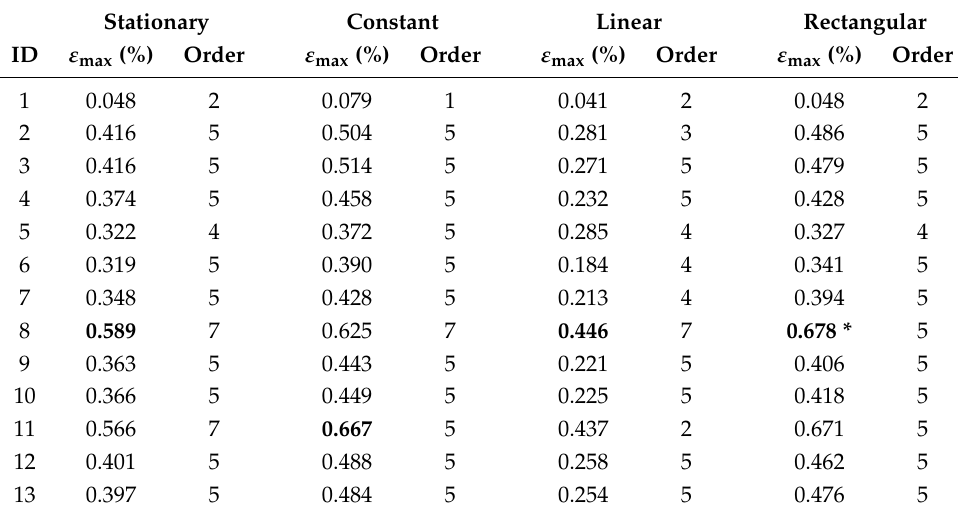
Table A1. Maximum errors obtained for each validation